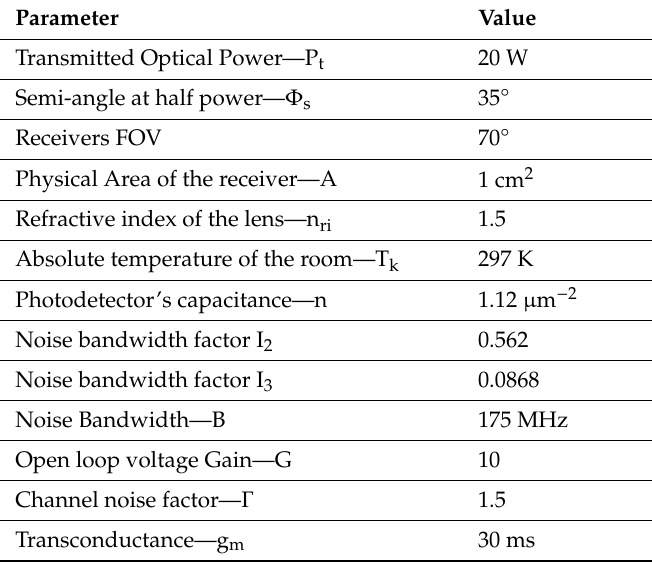
Table 1. Values of noise and system